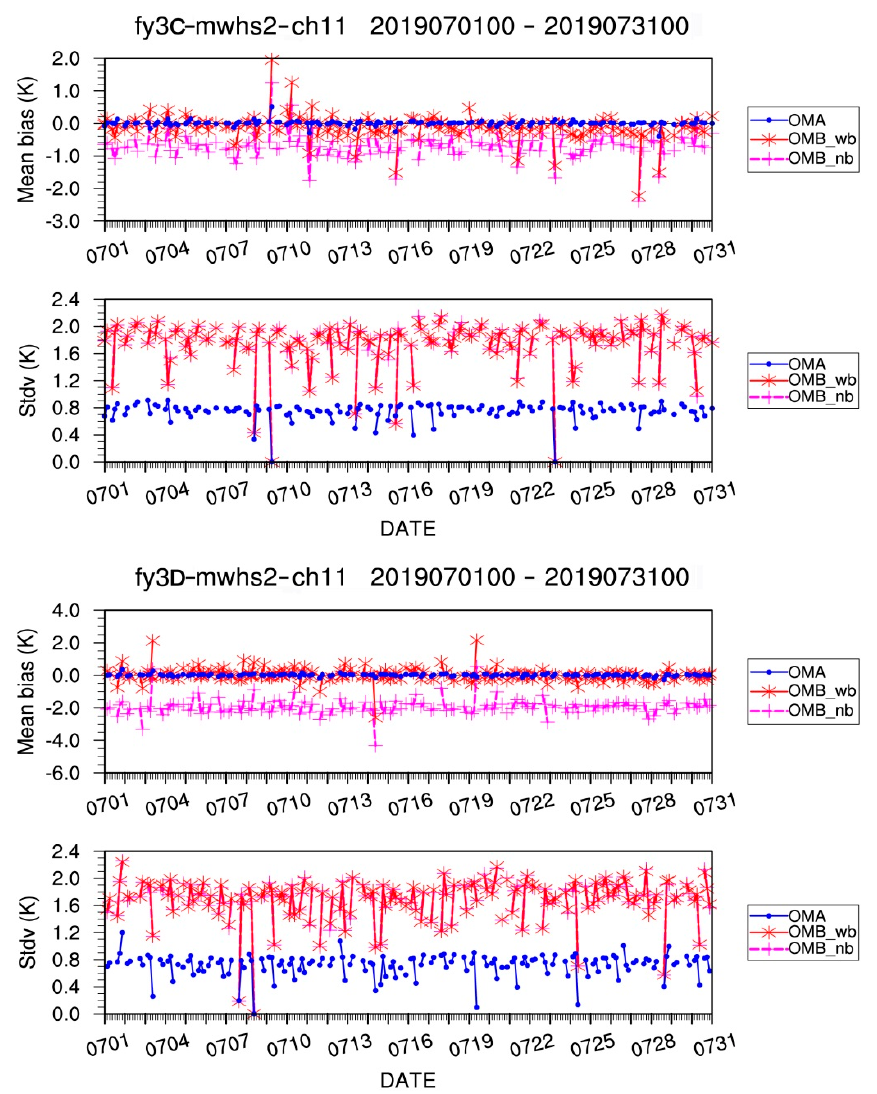
Figure 6. Varieties of the mean bias and the standard deviation over time from 0000 UTC on 1 July 2019 to 2300 UTC on 31 July 2019 for the background and the analysis departures in MWHS channle 11 on the satellite of FY-3C and FY-3D.